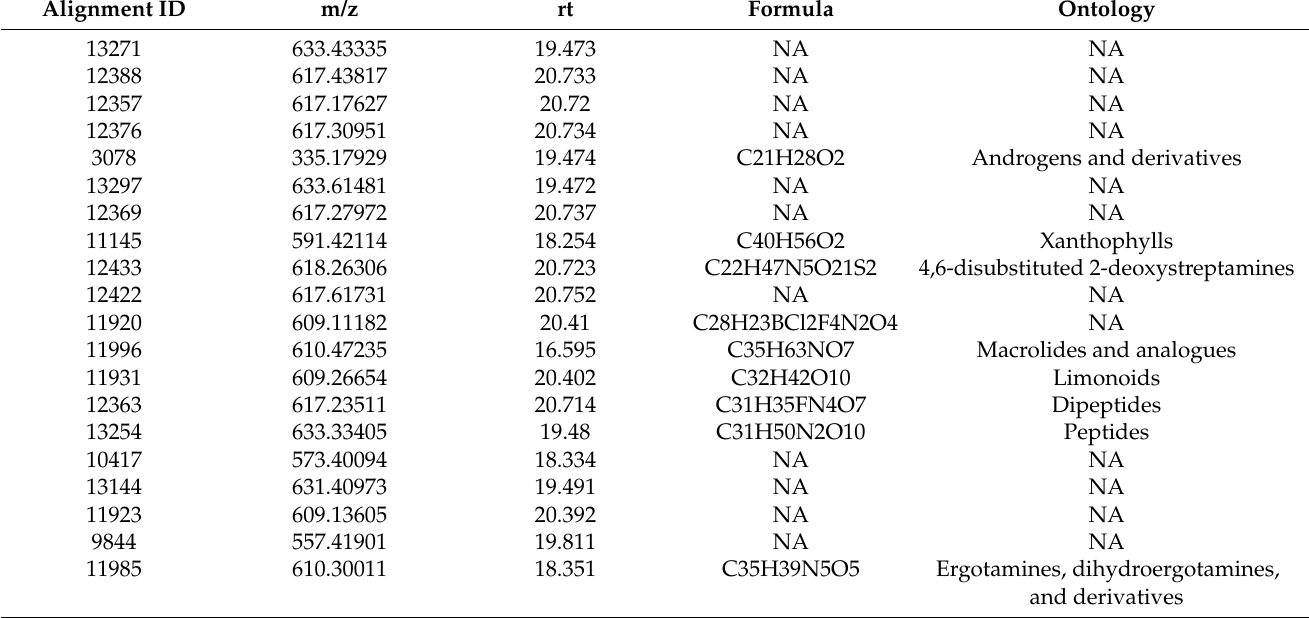
Table 1. Suggested compounds in F15-16 subfractions from MetaboAnalyst and